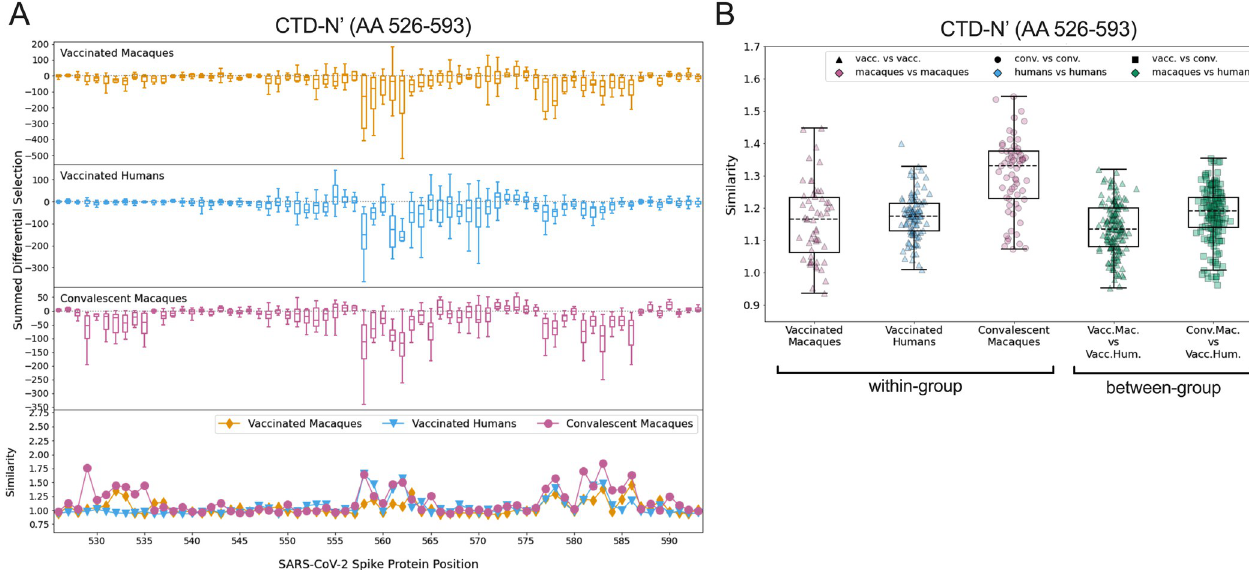
Fig 3. Comparison of escape profiles in the CTD-N’. (A) The top three panels show boxplots depicting the summed differential selection values of all individuals in a group at each locus, with each data point representing a different individual. The box represents median and interquartile range (IQR), the lower whisker represents the lowest data point above Q1-1.5IQR, and the upper whisker represents the highest data point below Q3+1.5IQR. Negative values represent sites where the binding interaction between antibody and peptide was weakened when peptides were mutated, whereas positive values represent enhanced binding. The bottom panel shows the mean escape similarity score for all pairwise comparisons between samples in each group, calculated at every locus. See S4 Fig for a description of the escape similarity score algorithm. (B) Within- and between-group region-wide escape similarity scores, with each point representing a pairwise comparison between two samples. The box represents median and interquartile range (IQR), the lower whisker represents the lowest data point above Q1-1.5IQR, and the upper whisker represents the highest data point below Q3+1.5IQR. The contribution of a site’s score to the total escape similarity score is weighted based on its relative contribution to the summed differential selection values across the region. P values are not computed due to lack of independence between data points.